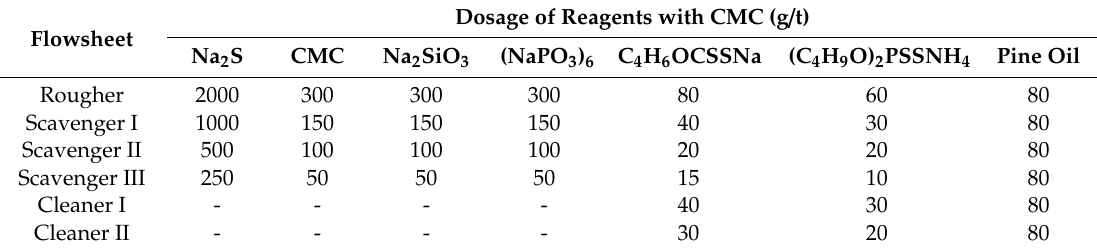
Figure 11. Flow-sheets of open circuit test. Table 6. Regent regime of open circuit test.